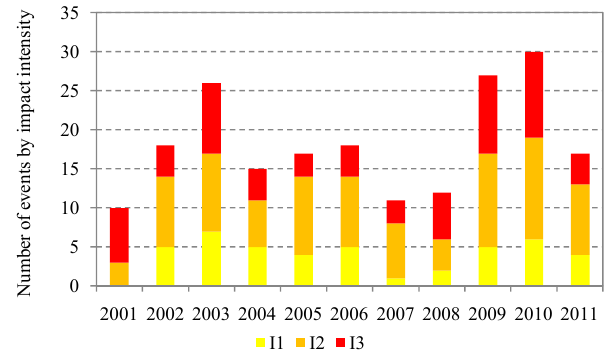
Fig. 3. Monthly distribution of high-impact weather events by im- pact intensity, for the period